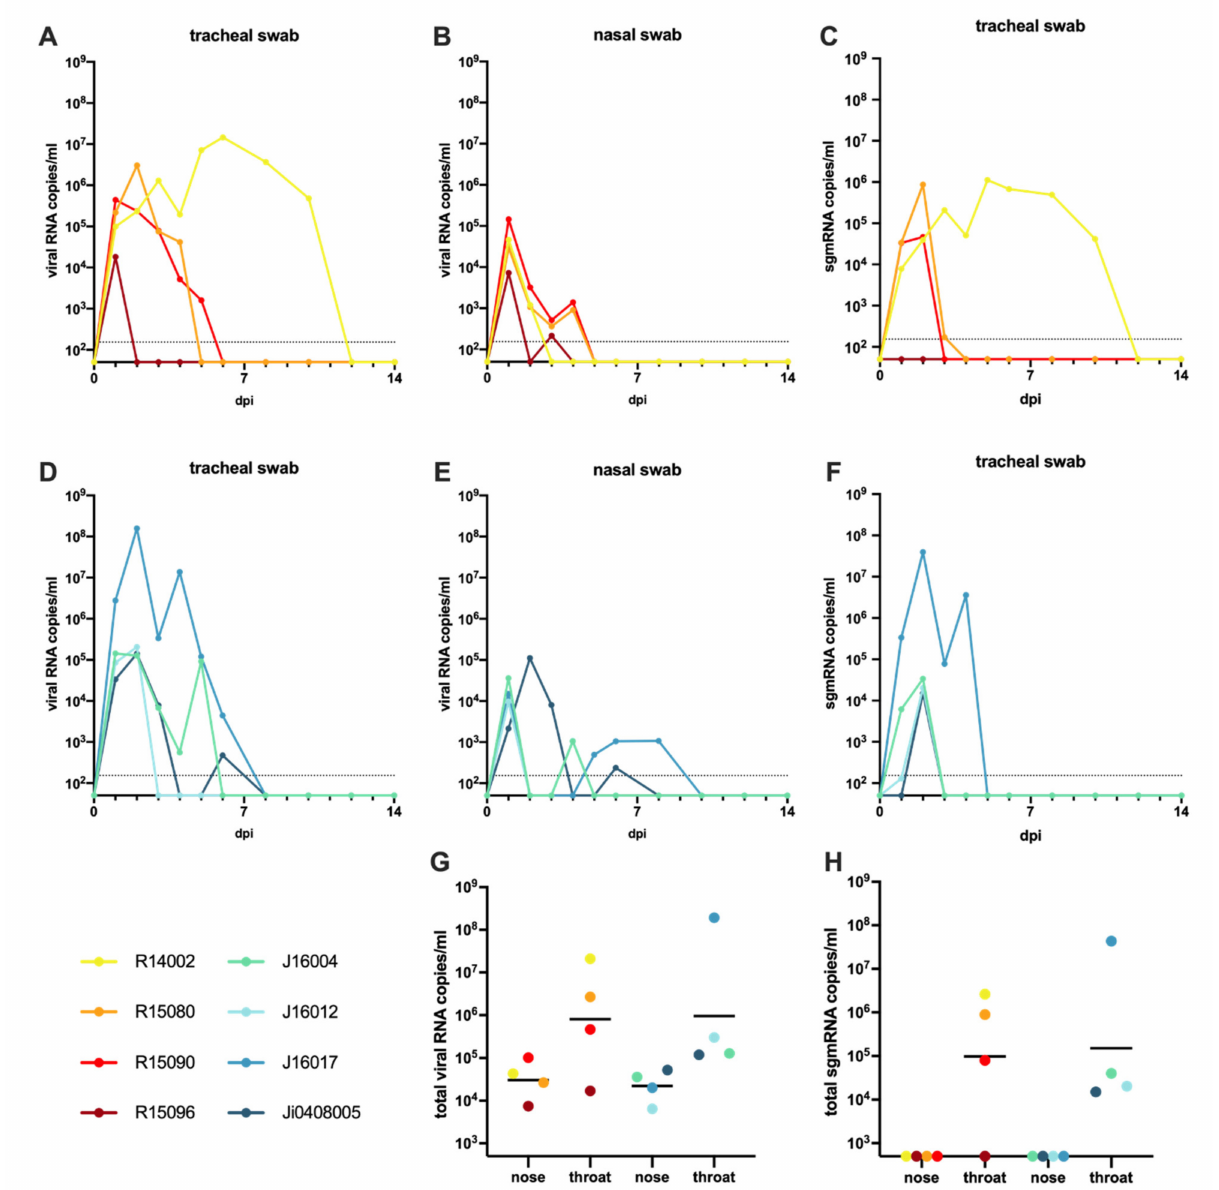
Figure 1. Virus loads in swab samples of macaques following SARS-CoV-2 infection. Viral RNA and subgenomic messenger RNA quantification in tracheal and nasal swabs of rhesus and cynomolgus macaques by qRT-PCR. The limit of quantification is indicated by the dotted horizontal line. Swabs after 14 dpi were all negative in PCR analysis and are therefore not shown for improved clarity. Viral RNA levels in tracheal ( A ) and nasal swabs ( B ), and sgmRNA levels in tracheal swabs ( C ) of rhesus macaques. Viral RNA levels in tracheal ( D ) and nasal swabs ( E ), and sgmRNA levels in trachea swabs ( F ) of cynomolgus macaques. The limit of quantification is indicated by the dotted horizontal line. Total virus loads ( G ) and sgmRNA loads ( H ) in throat and nose samples of macaques throughout the study. Horizontal bars represent geometric means. The sum of the viral copies was calculated rather than the area under the curve (AUC), as AUC interpolates for time points when virus loads were not determined. The color coding used for each individual animal as shown in the figure is used throughout the manuscript to denote the same individual. Rhesus macaques are indicated by yellow to red colors; cynomolgus macaques by green to blue